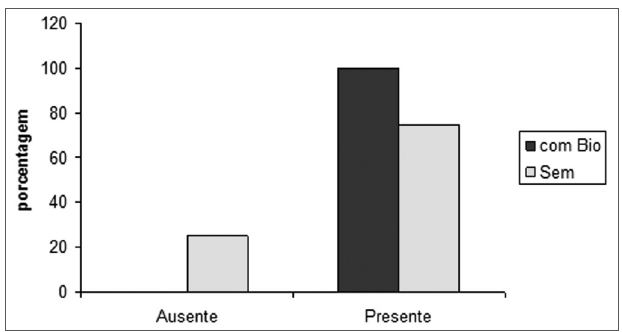
Figura 5. Porcentagem de animais que apresentaram ou não con- gestão, nos grupos controle (sem) e experimental (com Bio). (Prova de Fisher: p=0,308).